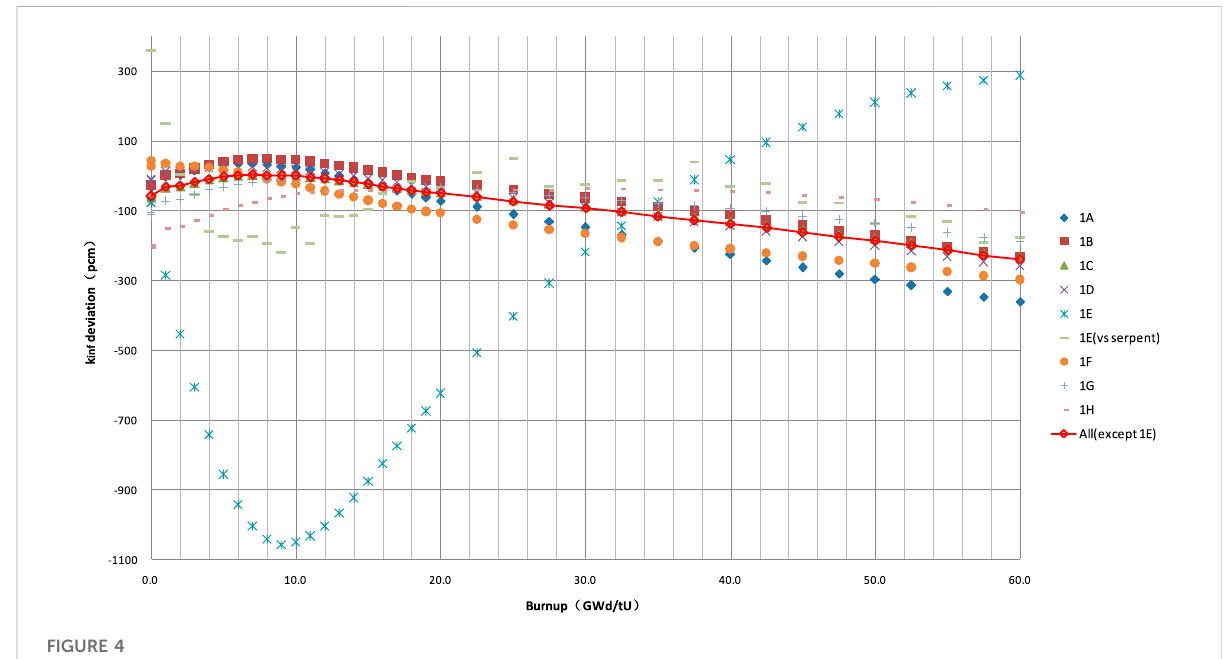
FIGURE 4 Deviation of in fi nite multiplication factor for VERA1 depletion